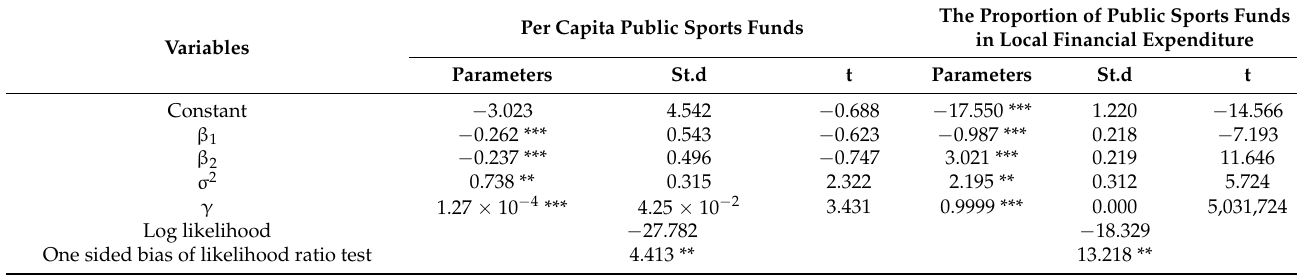
Table 1. SFA model estimation results of input slack variables.